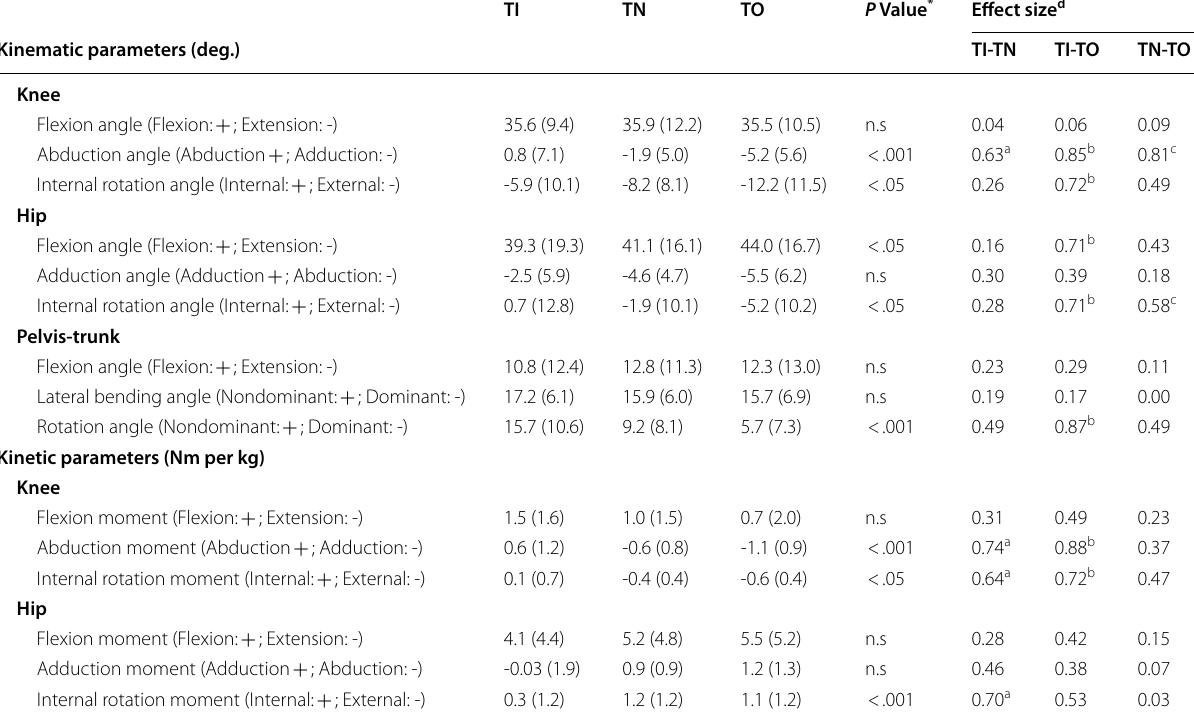
* Values determined using the Friedman test a Significant difference between Toe-in (TI) and Toe-neutral (TN) positions b Significant difference between TI land Toe-out (TO) positions c Significant difference between TN and TO position d Effect size was calculated using Wilcoxon signed-rank